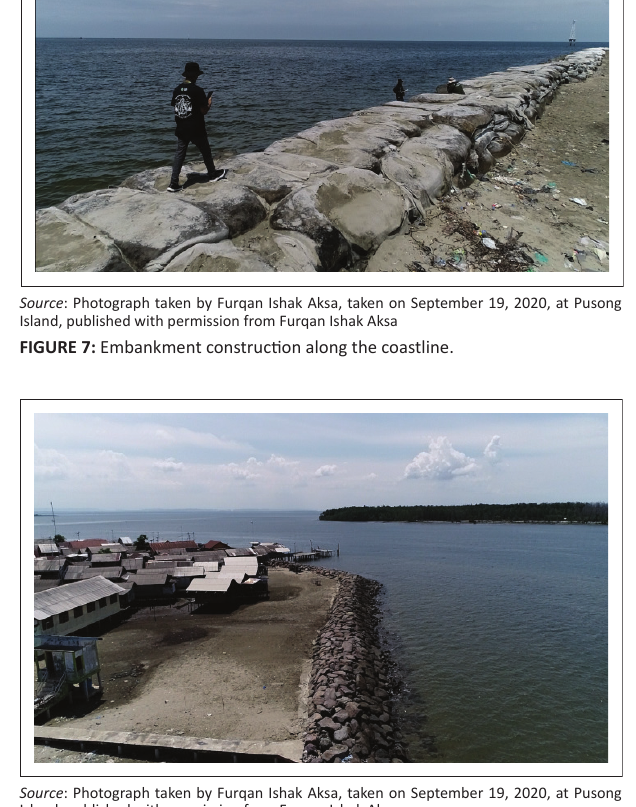
FIGURE 8: Embankments built along the coastline.